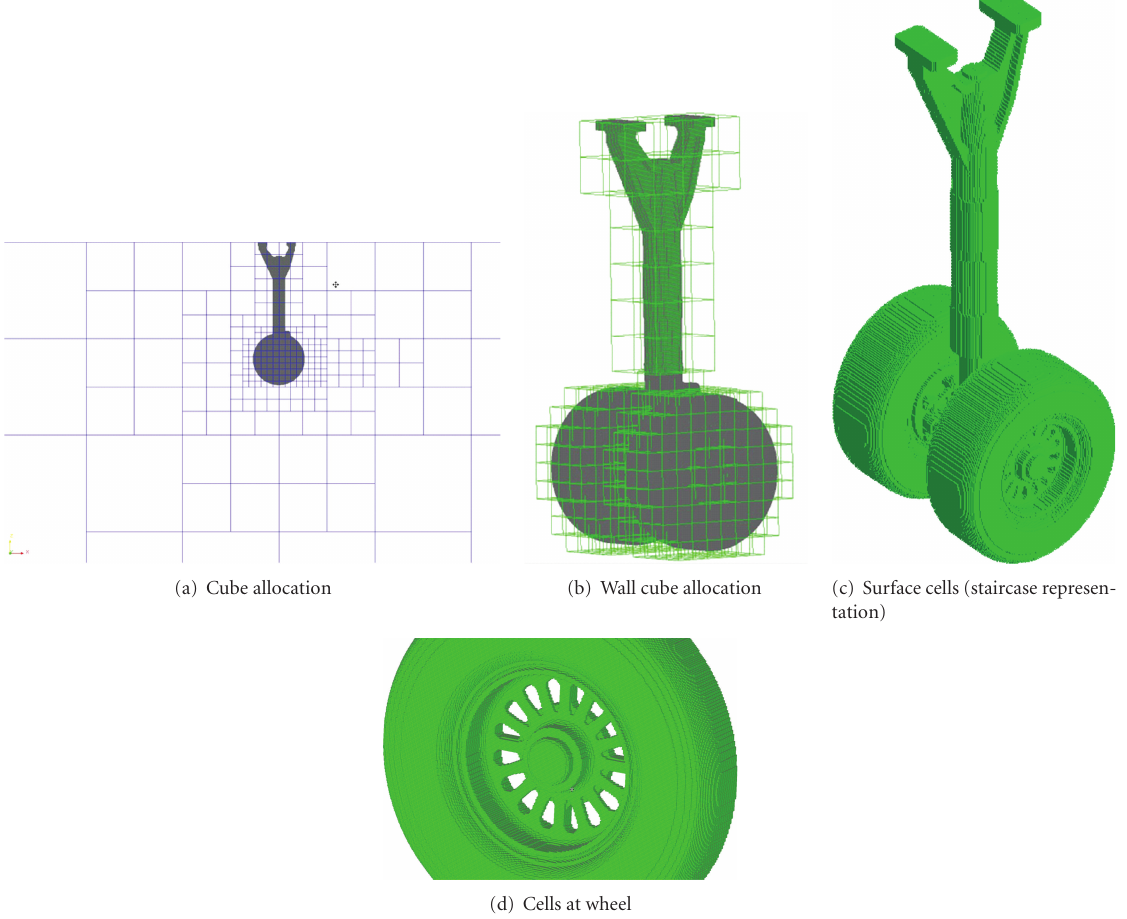
Figure 7: Computational mesh for LEG geometry.